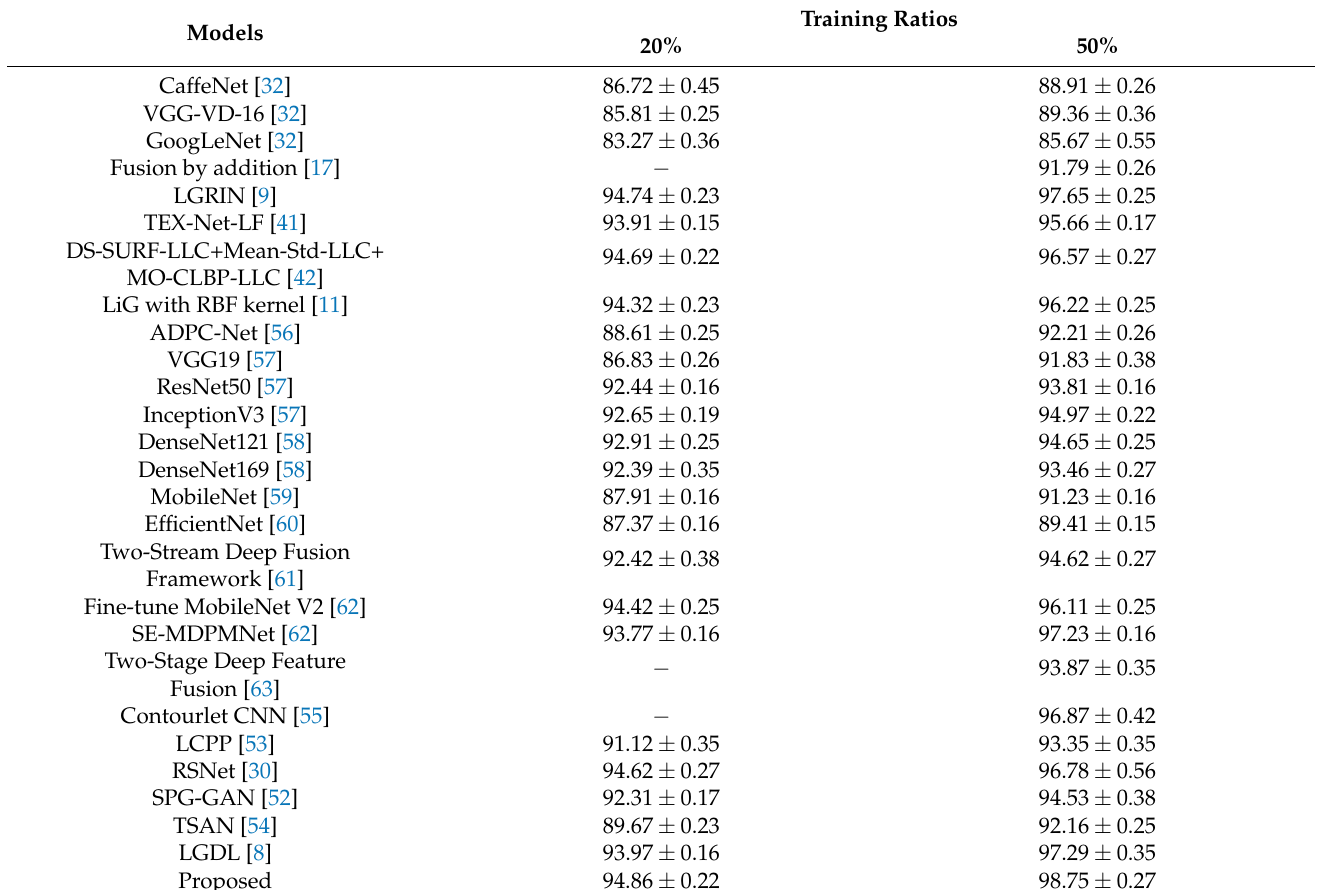
Table 3. Overall accuracies (%) of twenty-six kinds of methods and our method under the training ratios of 20% and 50% in URSIS.